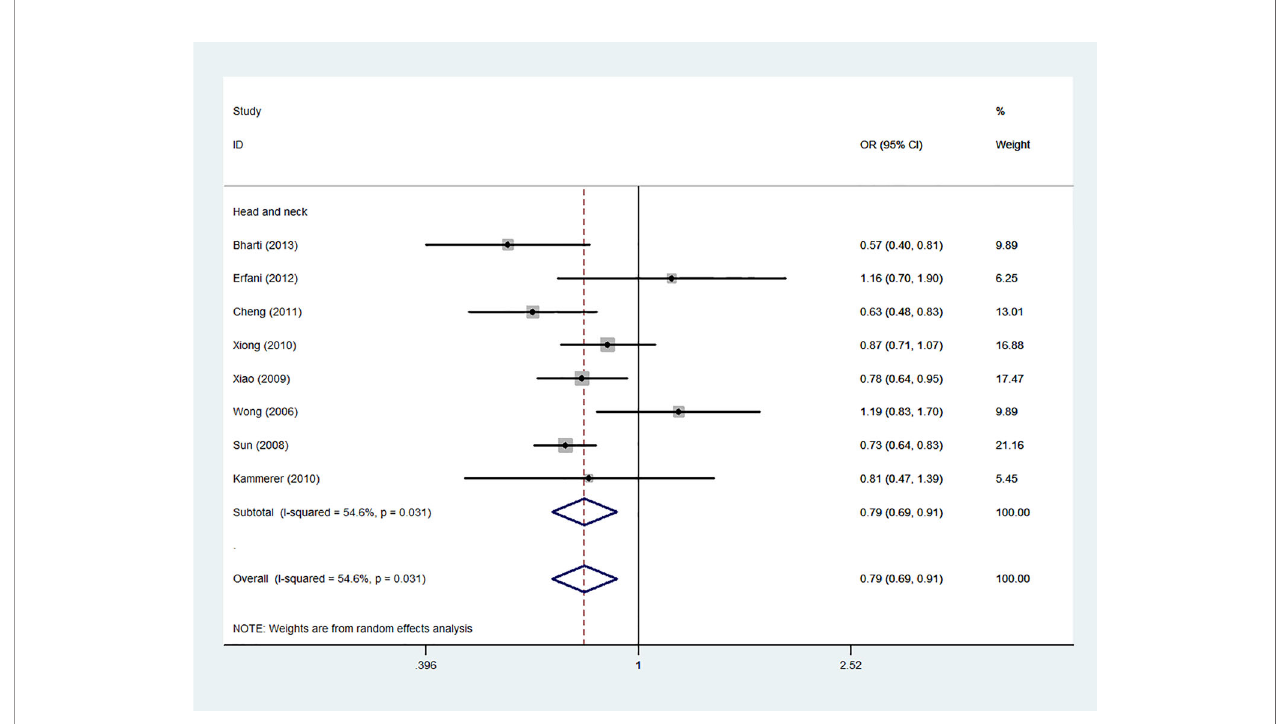
FIGURE 8 | Forest plot of the association between the CTLA-4 gene rs231775 polymorphism and head and neck cancer risk (G-allele vs.